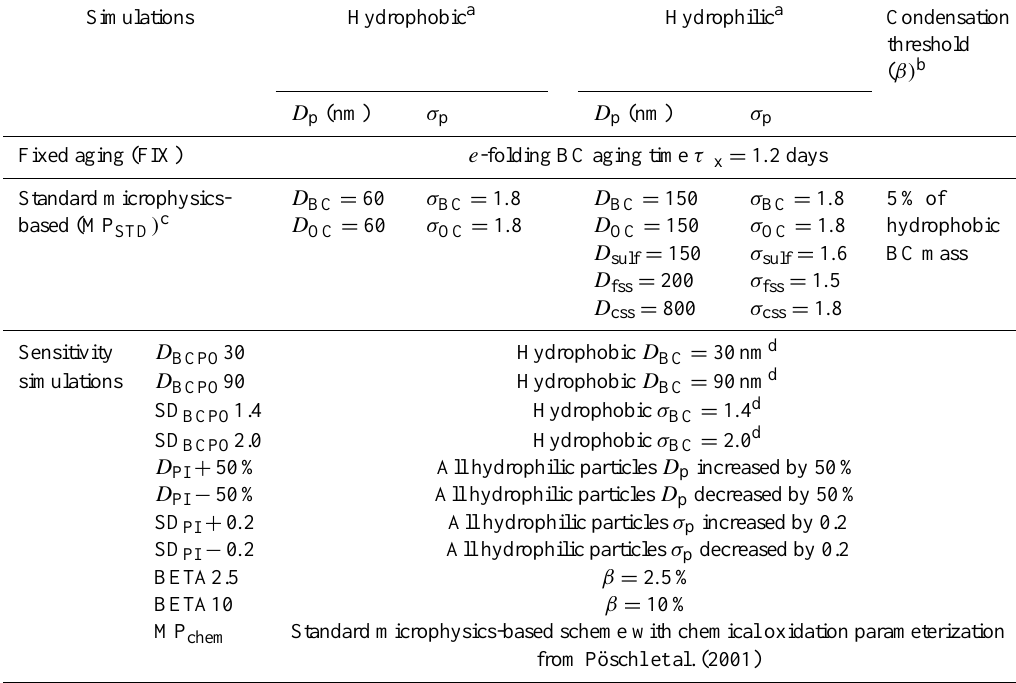
Table 1. Key aging parameters used in GEOS-Chem simulations of BC. Simulations Hydrophobic a Hydrophilic a